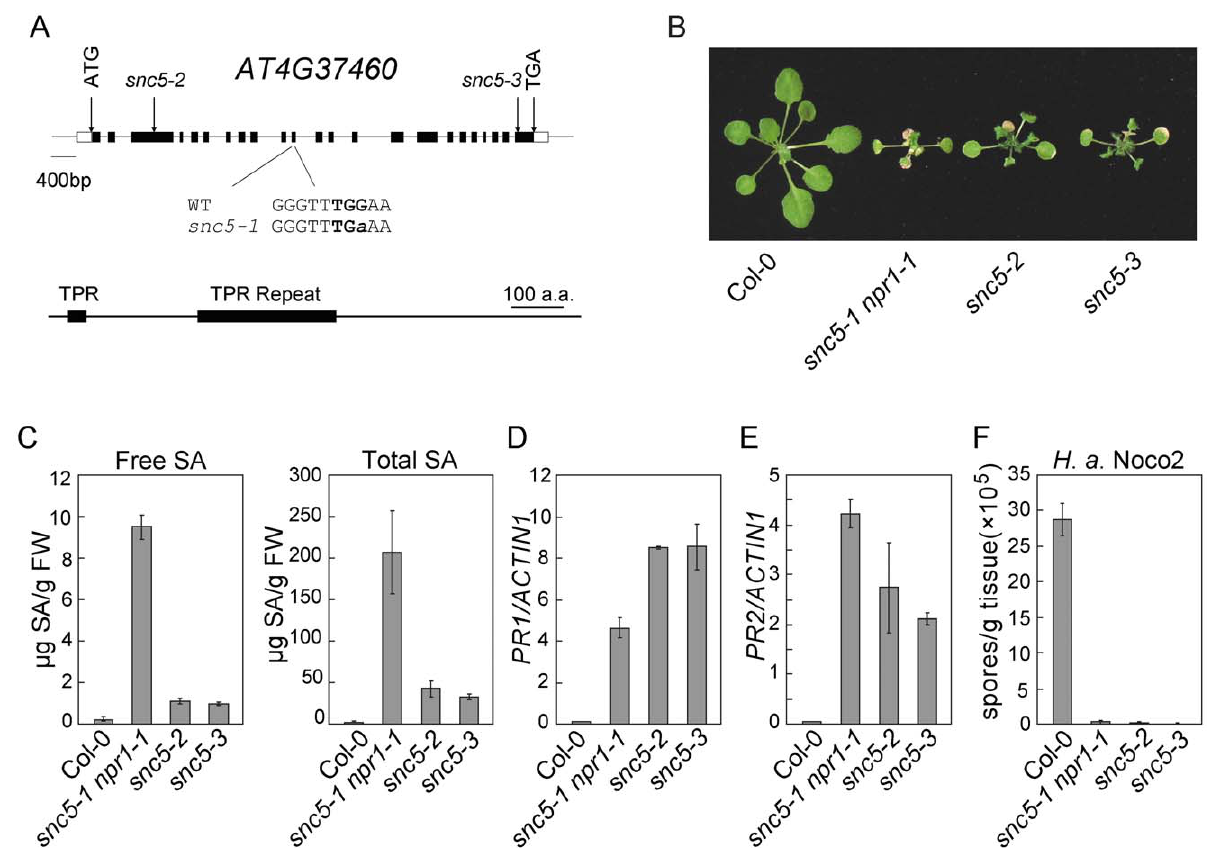
Figure 2. Map-based cloning of snc5-1 . (A) Gene structure of SNC5 ( At4g37460 ) and positions of the molecular lesions in snc5-1 , snc5-2 (SAIL_412_E08) and snc5-3 (SAIL_216_F11). Boxes are exons and lines indicate introns. (B) Morphology of wild type (Col-0), snc5-1 npr1-1 , snc5-2 and snc5-3 plants grown on soil. The picture was taken when the plants were four weeks old. (C) Free and total SA levels in wild type (Col-0), snc5-1 npr1-1 , snc5-2 and snc5-3 . Error bars represent standard deviation from four measurements. (D–E) Expression levels of PR1 (E) and PR2 (F) in wild type (Col-0), snc5-1 npr1-1 , snc5-2 and snc5-3 compared to Actin 1 . Error bars represent standard deviation from three measurements. (F) Growth of H. a. Noco2 spores on wild type (Col-0), snc5-1 npr1-1 , snc5-2 and snc5-3 . Error bars represent standard deviation from three